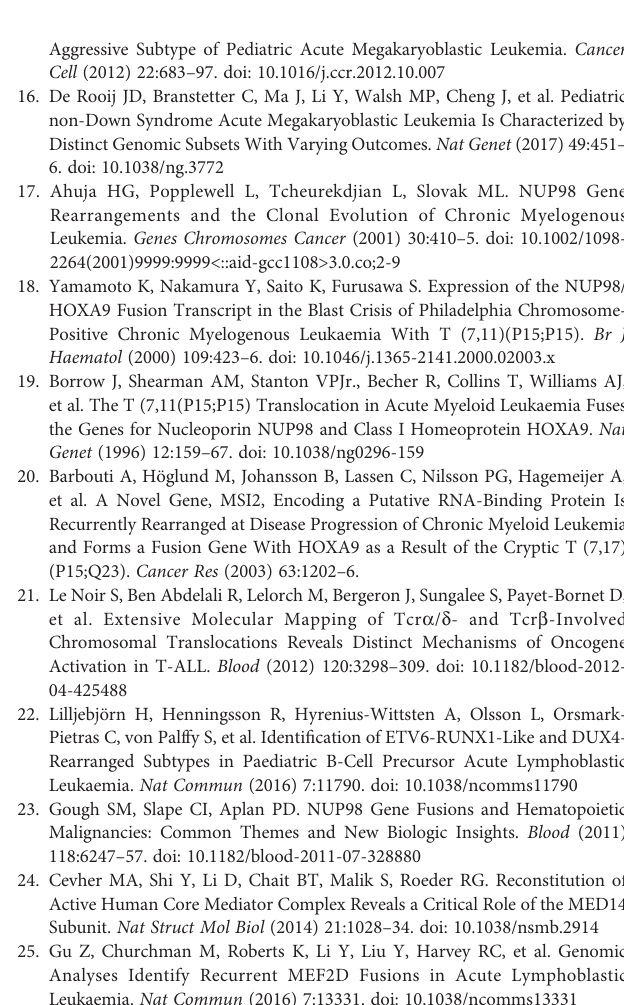
Supplementary Table 3 | Detectionof43fusiongenesbyamultiplexRT-PCRpanel. Supplementary Table 4 | Gene mutations detected by NGS and RNA sequencing. Supplementary Table 5 | Detection of 222 genes by a NGS panel. Supplementary Table 7 | Clinical characteristics of two patients with the MED14-HOXA9 fusion